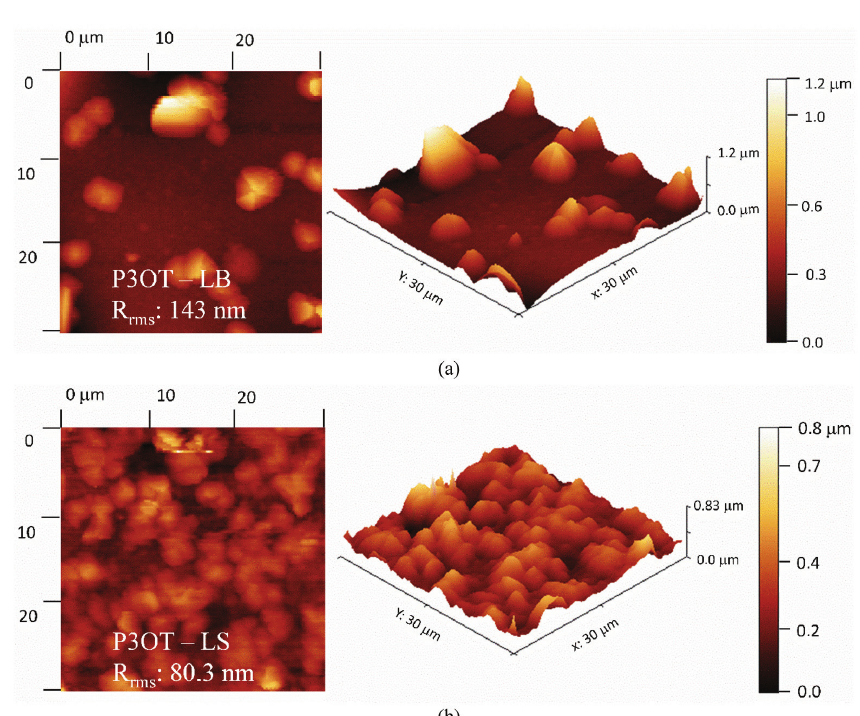
Figure 6. AFM topographic images of a) LB and b) LS P3OT/54SA films with 25